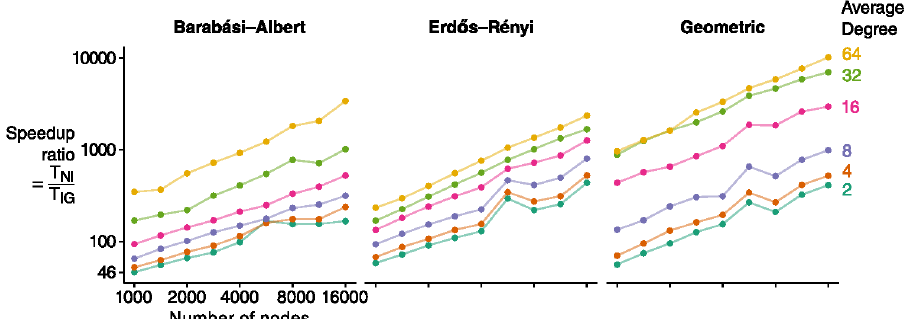
Fig 5. IncGraph is significantly faster than non-incremental approaches. For small networks, the execution time of IncGraph T IG is already 50 times less than that of non-incremental approaches T NI . This ratio increases even further for networks with higher numbers of nodes or higher average